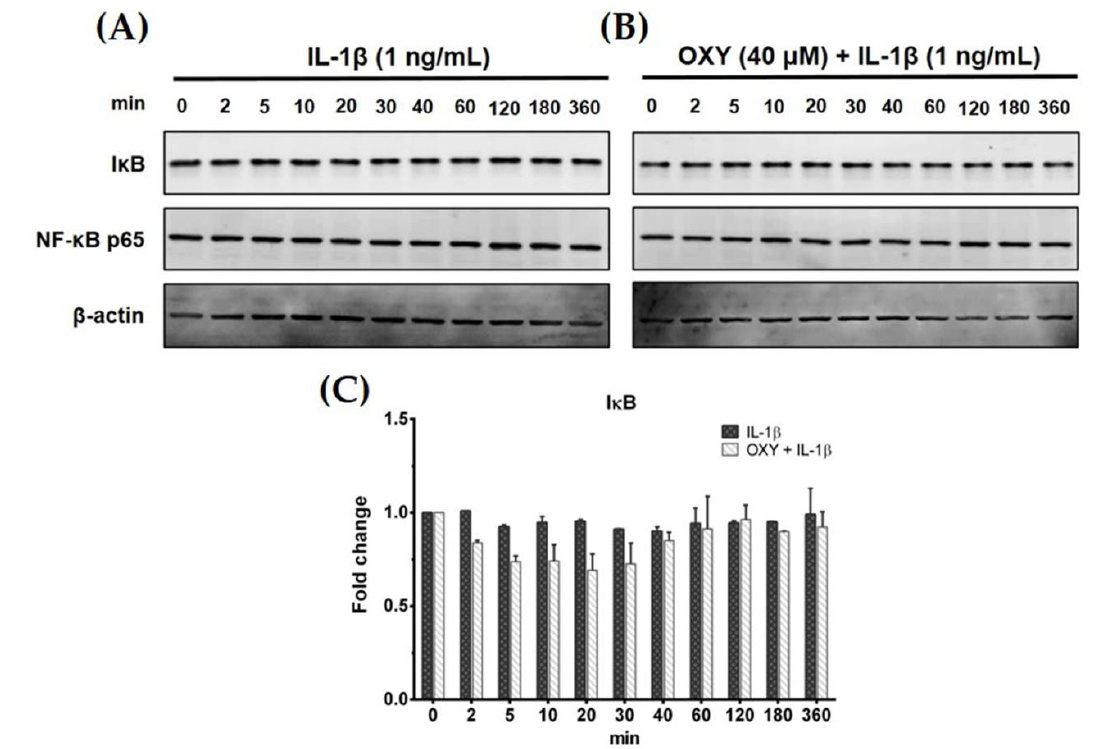
Figure 3. ( A ) E ff ects of OXY on the expression level of I κ B in HMC3 cells induced by IL-1 β for various Figure 3. ( A ) Effects of OXY on the expression level of IκB in HMC3 cells induced by IL-1β for various time points (0–360 min); ( B ) the e ff ects of OXY on the expression level of I κ B after IL-1 β stimulation for time points (0–360 min); ( B ) the effects of OXY on the expression level of IκB after IL-1β stimulation various time points. NF- κ B p65 subunit was detected and used as an internal control; ( C ) quantitative for various time points. NF-κB p65 subunit was detected and used as an internal control; ( C ) analysis for I κ B expression. Data are represented as mean ± SD of three independent quantitative analysis for IκB expression. Data are represented as mean ± SD of three independent experiments.